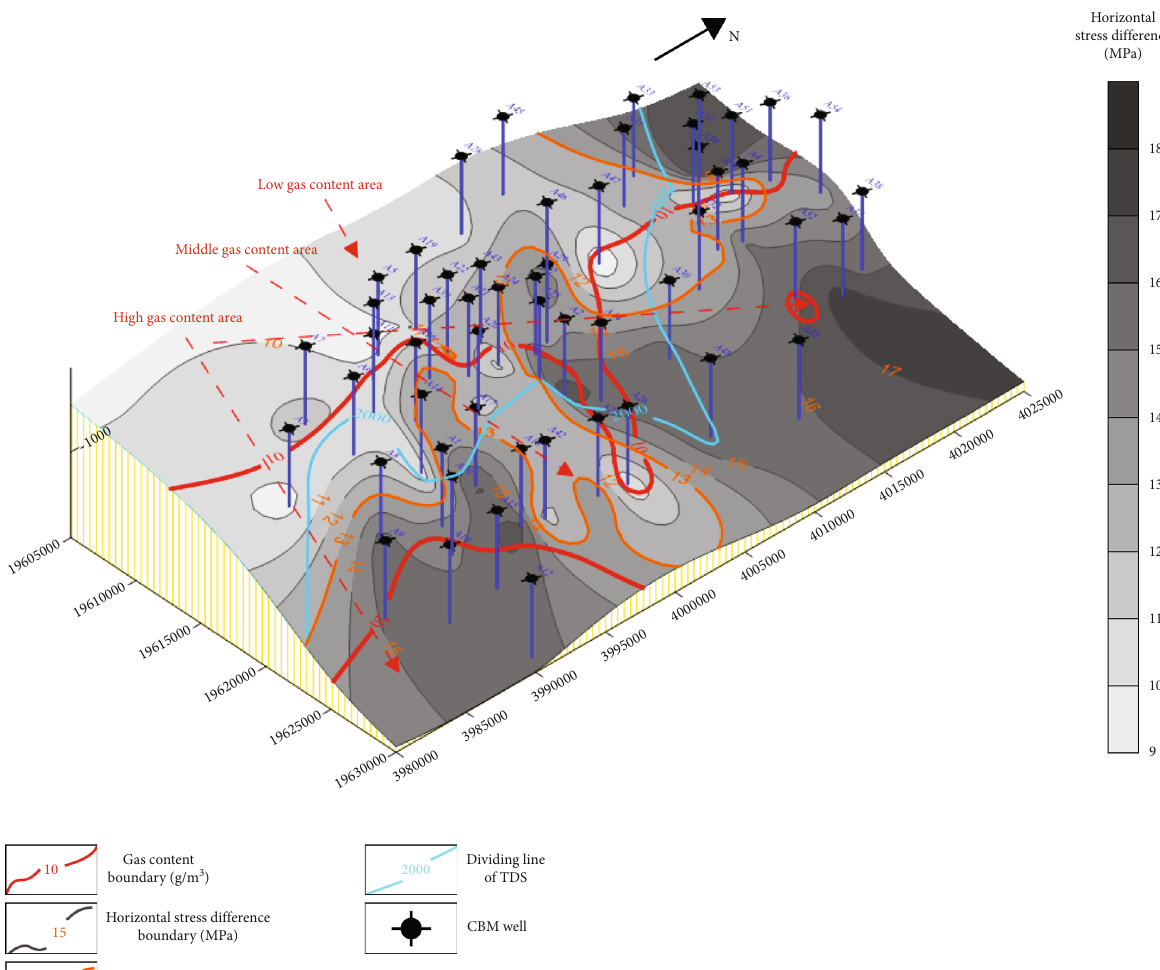
Figure 11: The distribution of CBM content under the combined e ff ect of hydrodynamic fi eld and geostress fi